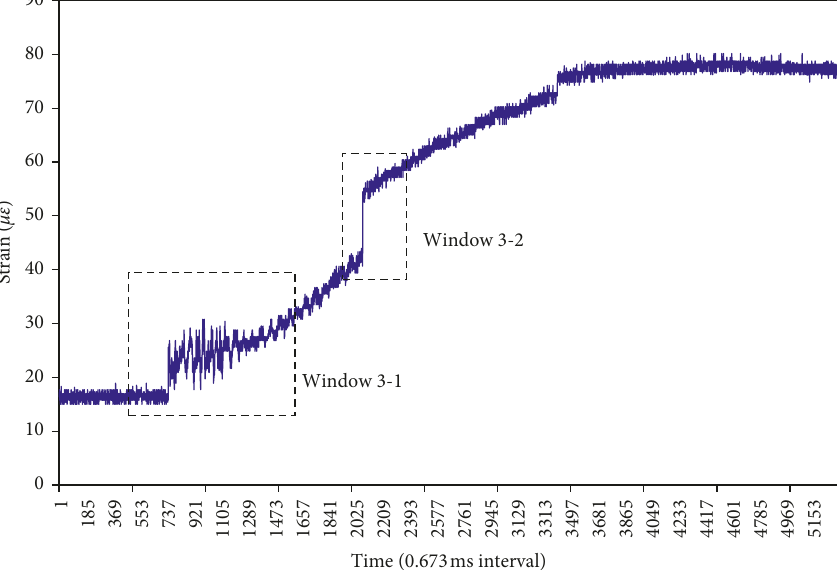
Figure 22: Third test full-term data.